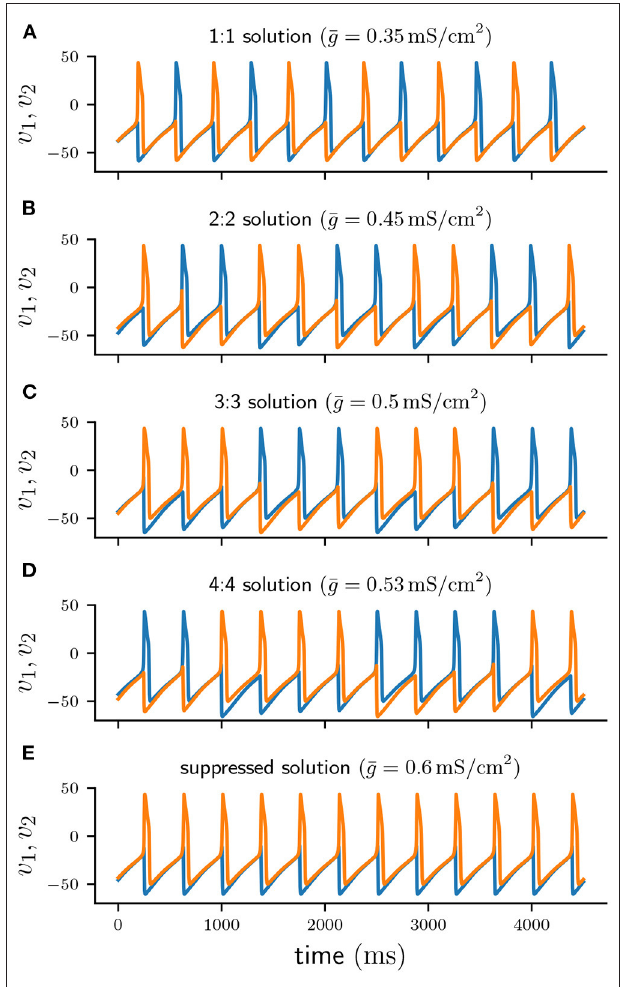
FIGURE 2 | Voltage traces of cell 1 (blue) and cell 2 (orange) of numerically stable solutions. (A–D) 1 : 1, 2 : 2, 3 : 3, and 4 : 4 anti-phase solutions for increasing values of ¯ g . (E) Suppressed